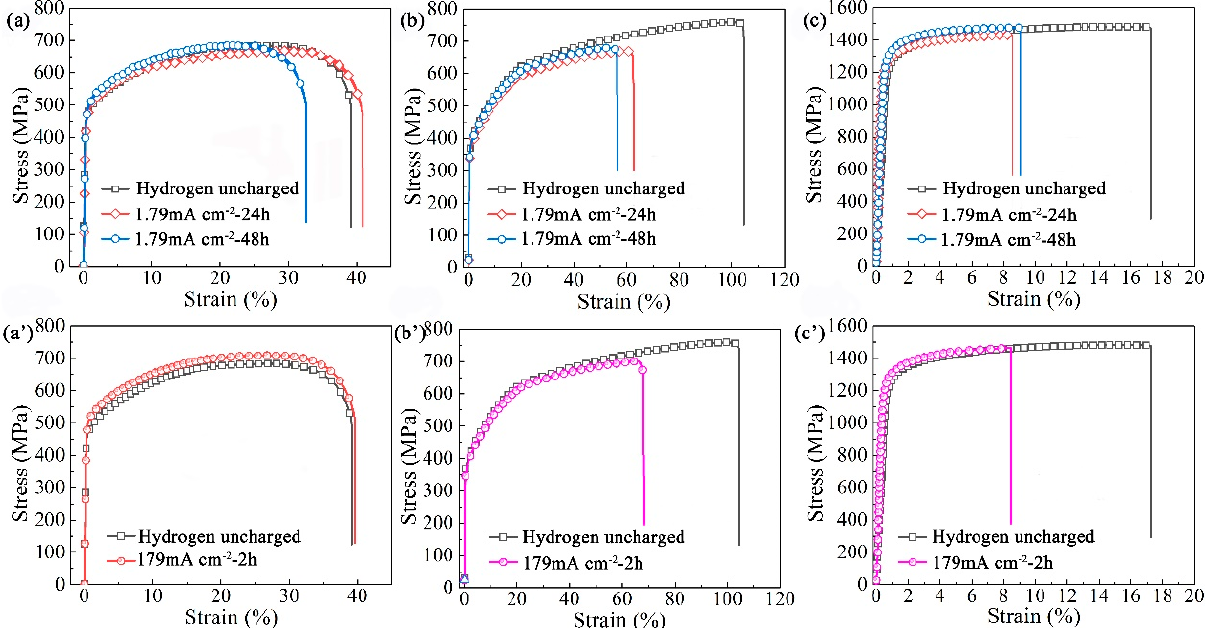
Figure 3. Engineering stress–strain curves of hydrogen-charged and uncharged CoCrFeMnNi ( a , a ′ ), 304 SS ( b , b ′ ), and IN718 ( c , c ′ ) at various hydrogen charging parameters.